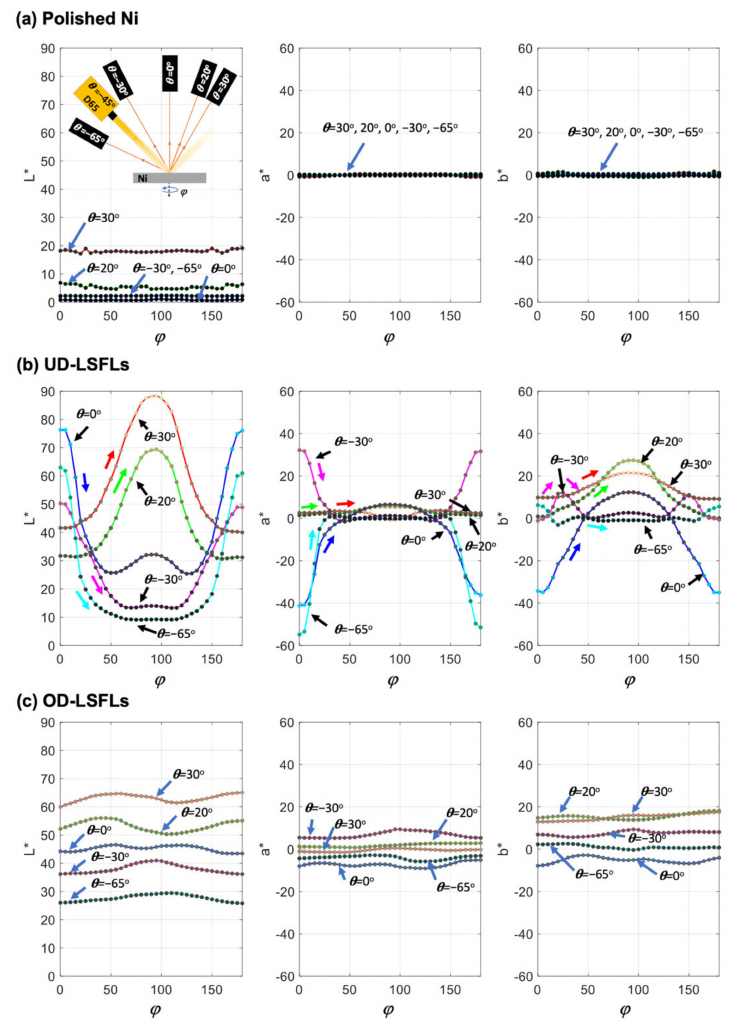
Figure 4. L* , a* , and b* in the CIELAB color space are measured in a rotation angle ( ϕ ) range of 0 ◦ to 180 ◦ on ( a ) the polished Ni surface, ( b ) UD-LSFLs on Ni, and ( c ) OD-LSFLs on Ni. Red, green, blue, magenta, and cyan solid lines are used to represent our colorimetric measurements at detection angles ( θ ) of 30 ◦ , 20 ◦ , 0 ◦ , − 30 ◦ , and − 65 ◦ , respectively. Each data point is represented by a small dot color-coded with actual angle-resolved true color. In ( b ), changing directions of L* , a* , and b* during an increase in ϕ from 0 ◦ to 90 ◦ are denoted by single-headed red, green, blue, magenta, and cyan arrows for detection angles of 30 ◦ , 20 ◦ , 0 ◦ , − 30 ◦ , and − 65 ◦ ,